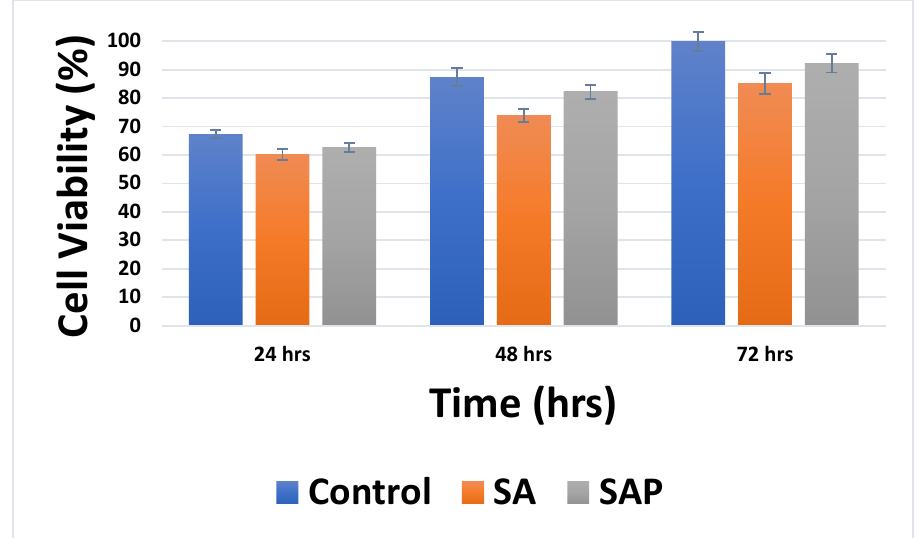
Figure 8. Survival rates of MDA-MB-231 cells on SA and SAP hydrogel discs. Bar charts represent mean percent viability in each case. Error bars represent ± standard deviation (SD for n = 3).